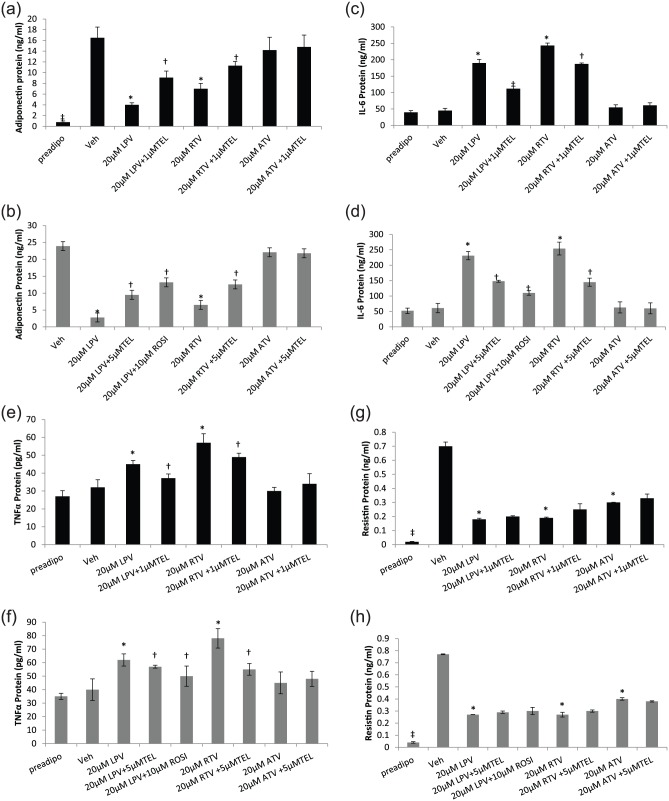
Adipokine secretion in differentiating 3T3-F442A and primary human
adipocytes following incubation with PIs with or without TEL or
ROSI: adiponectin: (a) 3T3-F442A and (b) primary human adipocytes;
IL-6: (c) 3T3-F442A and (d) primary human adipocytes and TNF-α: (e)
3T3-F442A and (f) primary human adipocytes; resistin: (g) 3T3-F442A
and (h) primary human adipocytes. ROSI was coincubated with LPV in
the primary human adipocyte model only. Data are expressed as mean
(n = 3) ± SD. (*p < 0.01, drug vs vehicle;
†p < 0.01, drug vs drug + TEL or
drug + ROSI; ‡p < 0.01, preadipocyte
vs vehicle.).Preadipo: preadipocyte; Veh: vehicle; RTV: ritonavir; LPV: lopinavir;
ATV: atazanavir; TEL: telmisartan; ROSI: rosiglitazone.